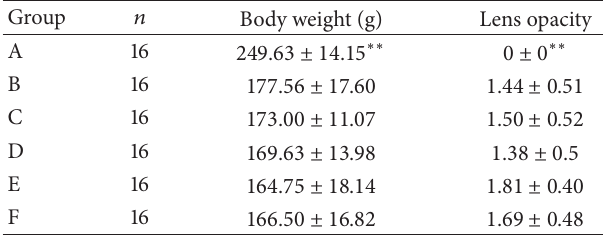
Table 1: The body weight and lens opacity of STZ-induced diabetic cataract in rats before rHV3 eye drops treatment ( 𝑥 ± 𝑠